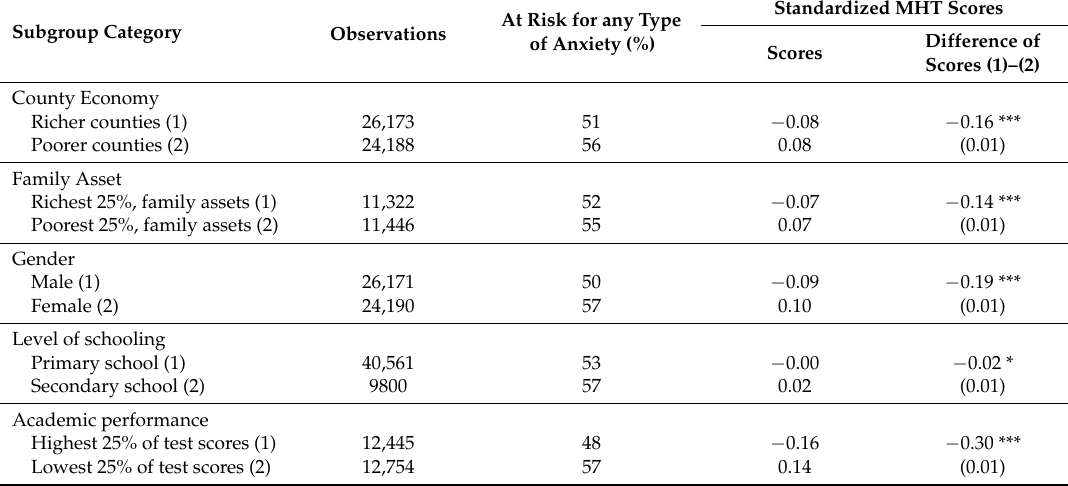
Table 3. The difference in risk for anxiety and standardized MHT scores across subgroups Subgroup